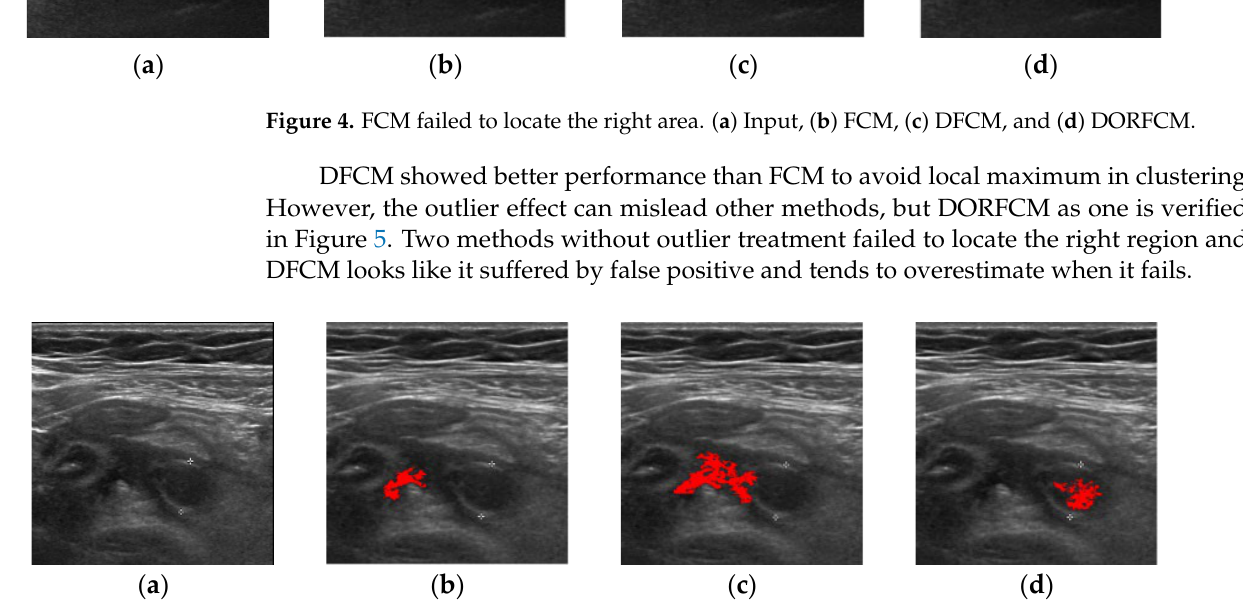
Figure 5. Only DORFCM succeeds. ( a ) Input, ( b ) FCM, ( c ) DFCM, and ( d ) DORFCM.